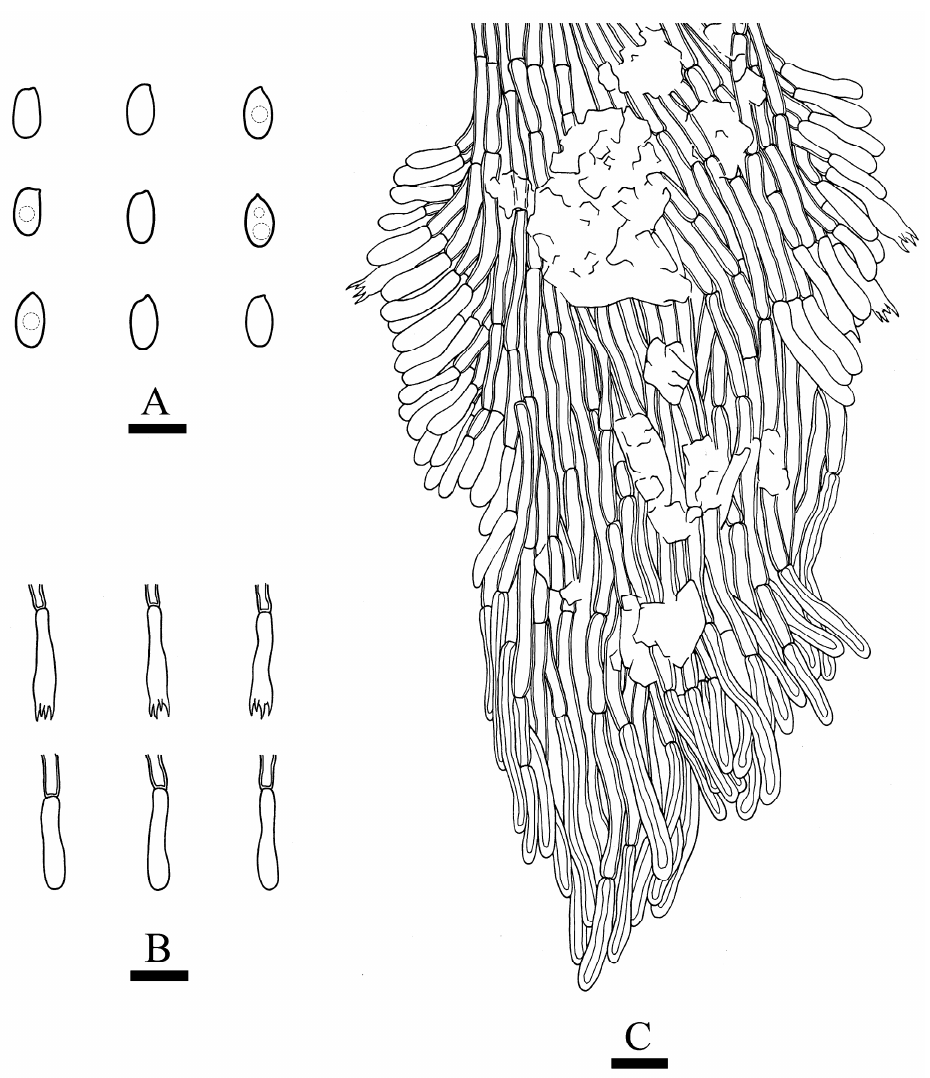
Figure 12. Microscopic structures of Mycoaciella brunneospina (drawn from CLZhao 15876, holotype). ( A ) Basidiospores. ( B ) Basidia and basidioles. ( C ) A section of hymenium. Bars: ( A ) = 5 µm, ( B , C ) = 10 µm.